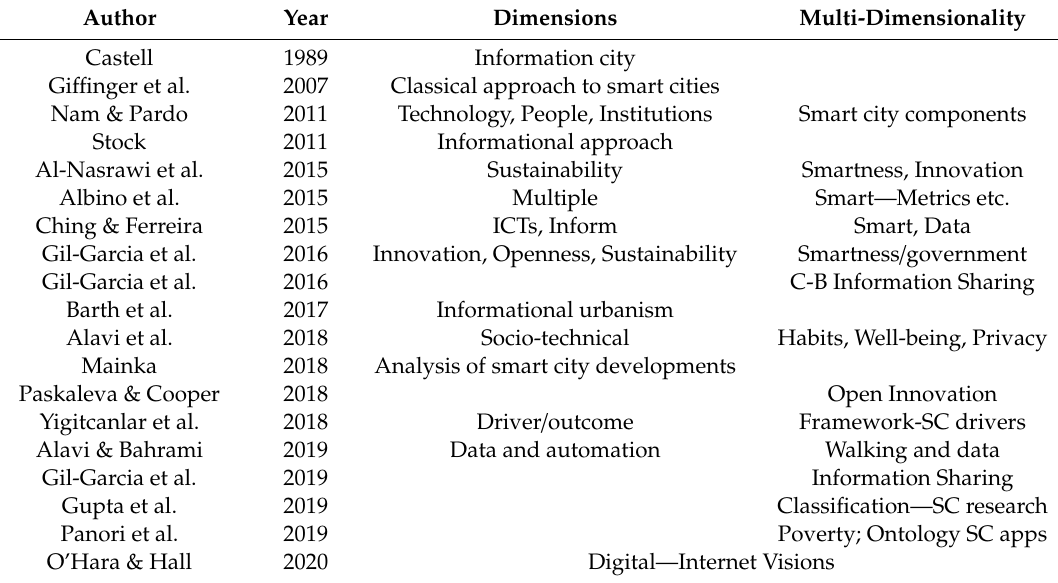
Table 1. Smart city dimensions and multi-dimensionalities by year,